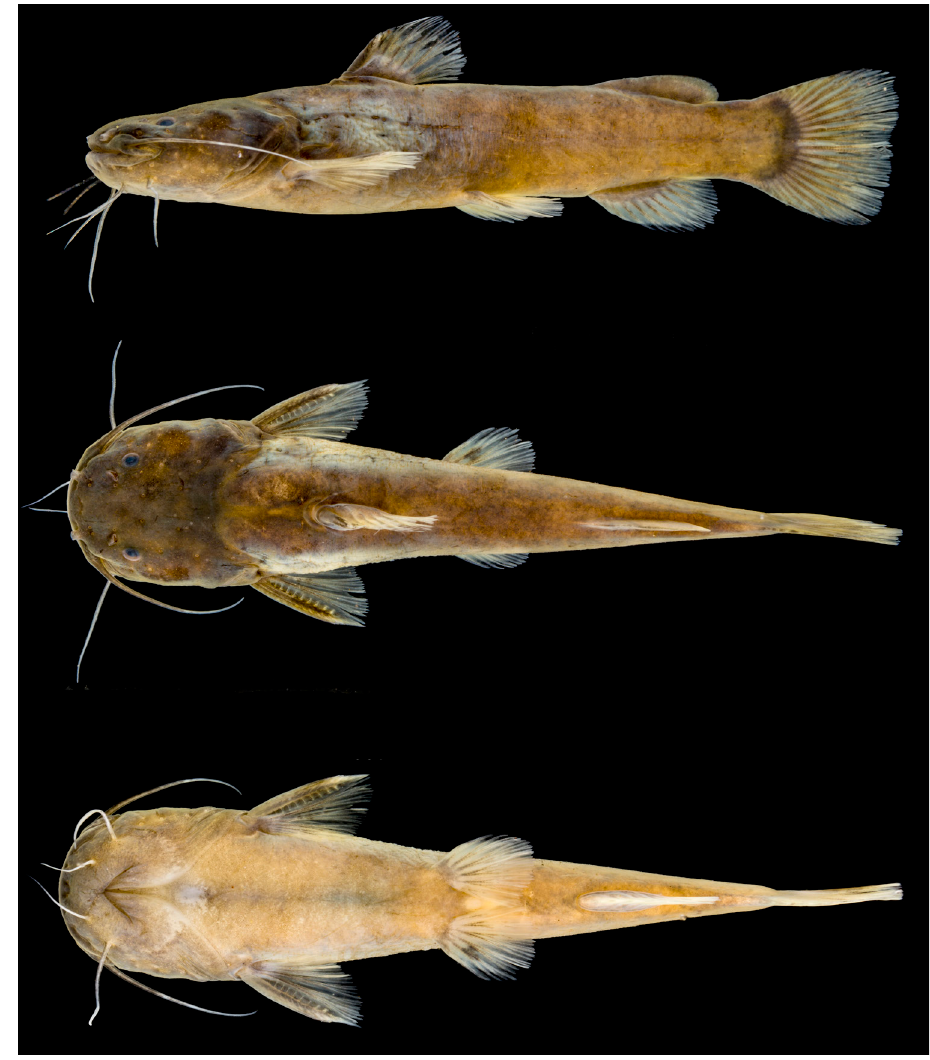
FIGURE 1 | Microglanis berbixae new species, MECN-DP-3944, holotype, male 54.2 mm SL.